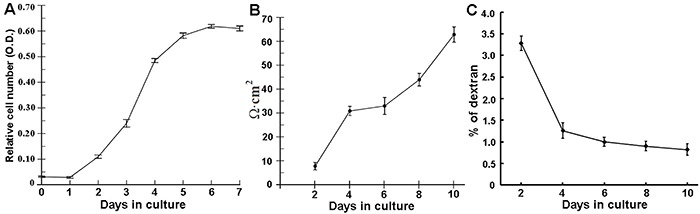
The cell proliferation log phase started after the lag phase of about 2 days with a sharper inclination (A). Cells were grown on the apical chamber of transwell-inserts. Transepithelial electrical resistance TEER was measured using an EVOM epithelial volt/ohm meter (B). Paracellular permeability was quantified by apical-to-basal flux of 10 kDa FITC-dextran (C). All samples were tested in triplicate. Data are reported as means±SD.